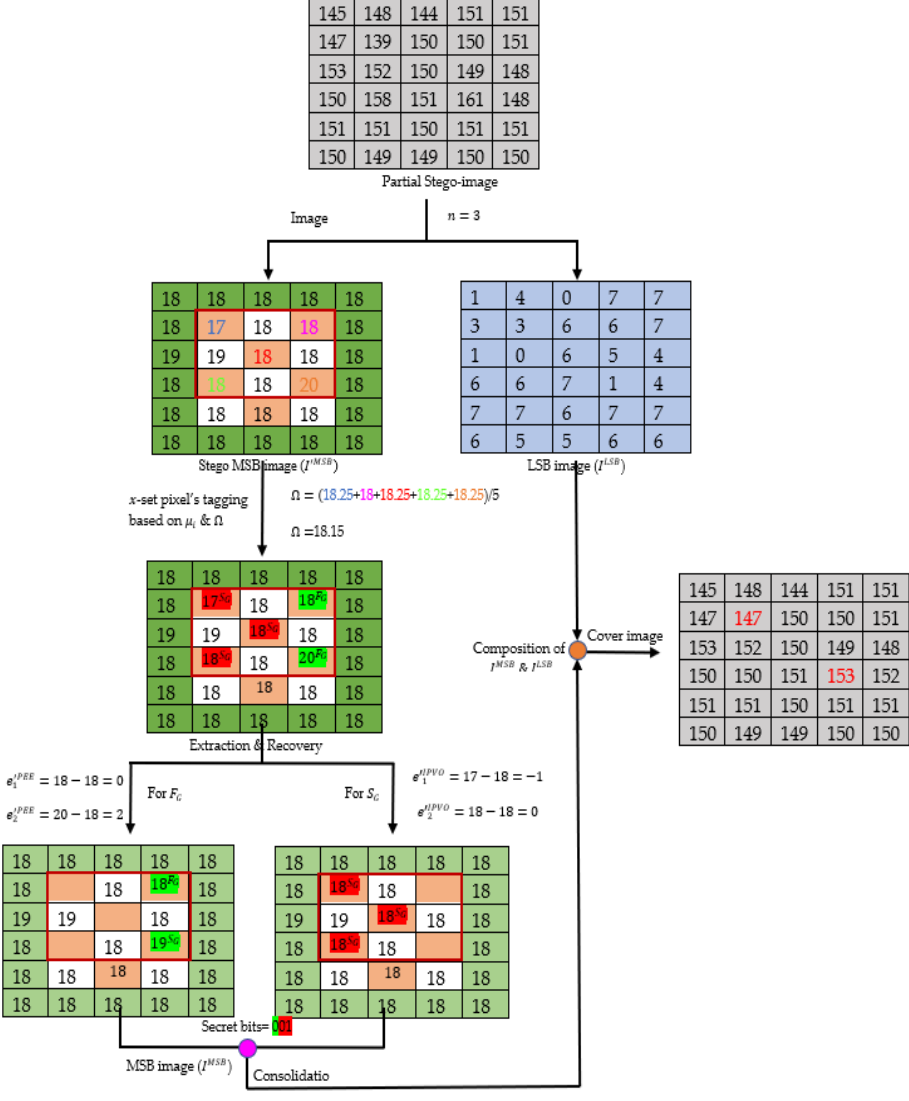
Figure 4. The proposed LM-RRDH extraction and recovery example.